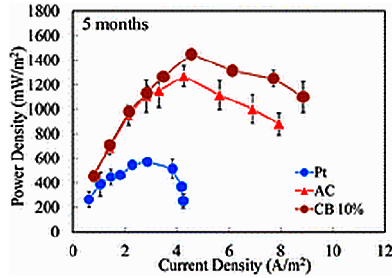
Figure 1. Power density and current density curve for microbial fuel cells (MFCs) operated for 5 months using Pt, activated carbon (AC), and 10% carbon black (CB)-blended AC (Reprinted with permission from Ref. [43]. Copyright (2014) American Chemical Society).